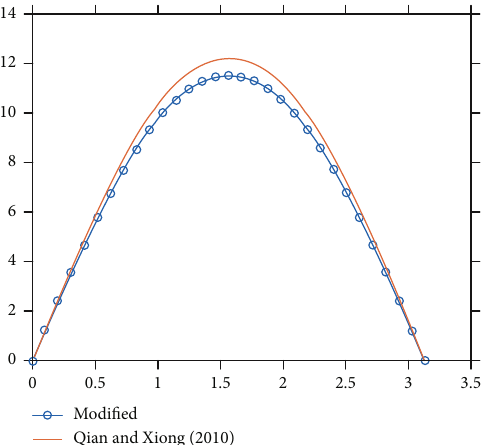
Figure 19: The variations of the system of equations (46) and the solution of the regularized system of equations (12) – (15) for p = 2 , k = , α = 0 : 0001 , and y = 1 .